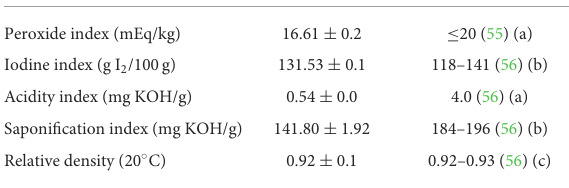
TABLE 3 Physicochemical characteristics of sunflower oil compared with Codex Alimentarius parameters.